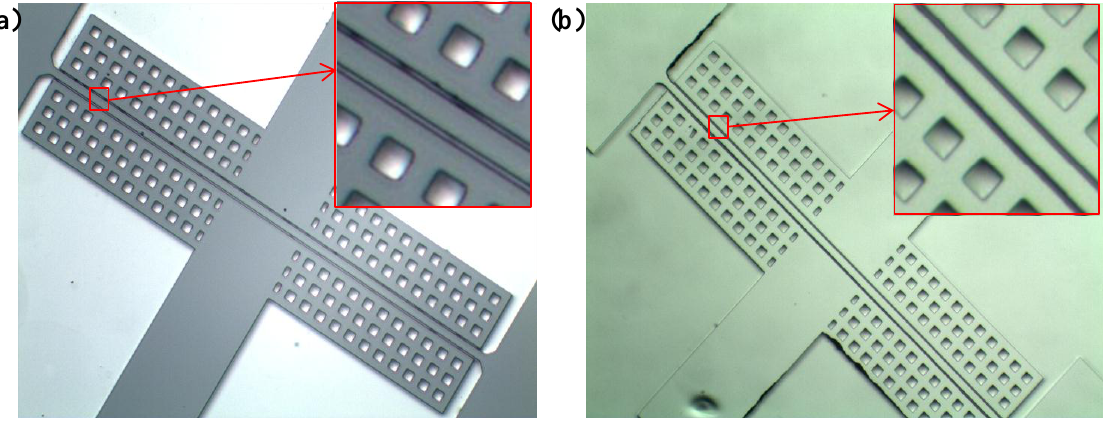
Figure 3. ( a ) Lateral pull-in damage (collapses between the resonant beam and driving/sensing electrode) after the step of anodic bonding; ( b ) The deposition of an Al film on the handle layer before anodic bonding can effectively avoid the pull-in